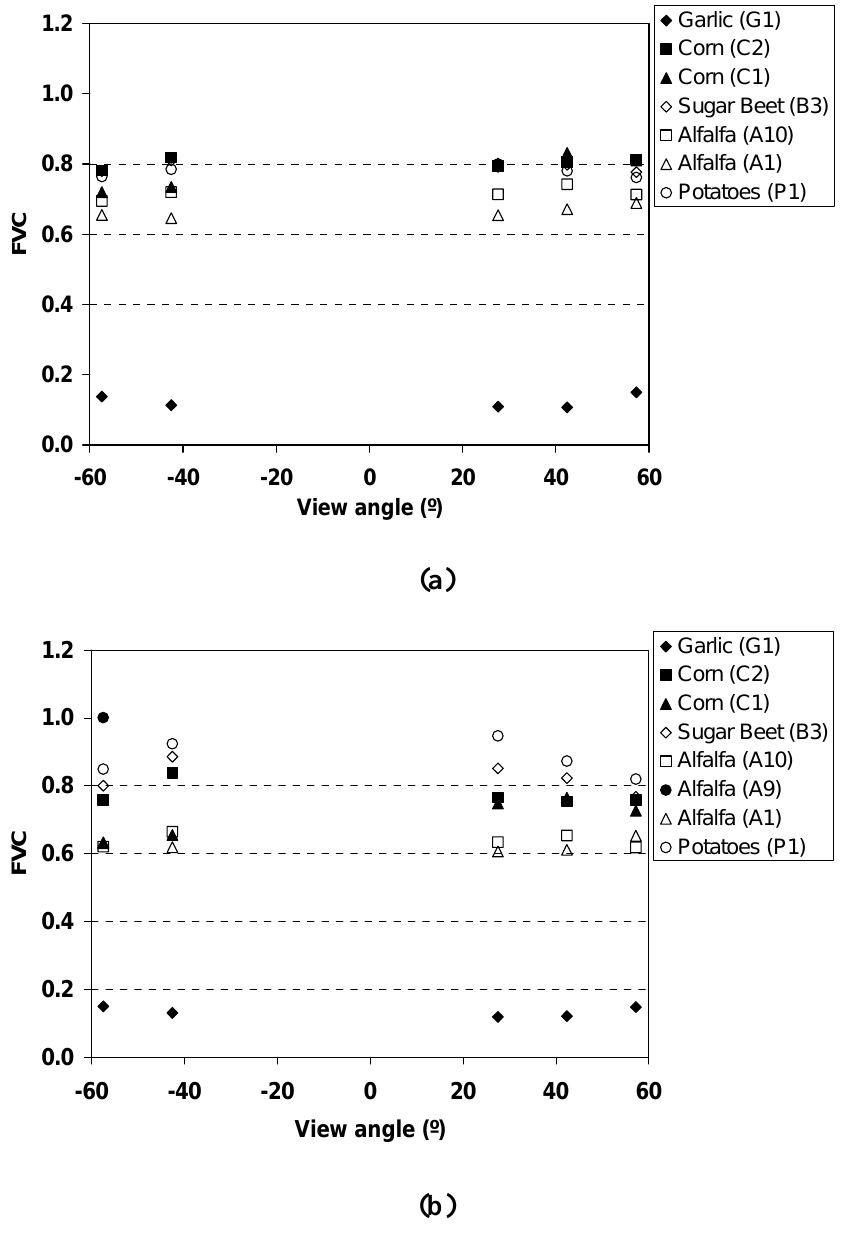
Figure 11. Fractional Vegetation Cover (FVC) retrieved from (a) NDVI and (b) VARIgreen versus the CHRIS view angle for different